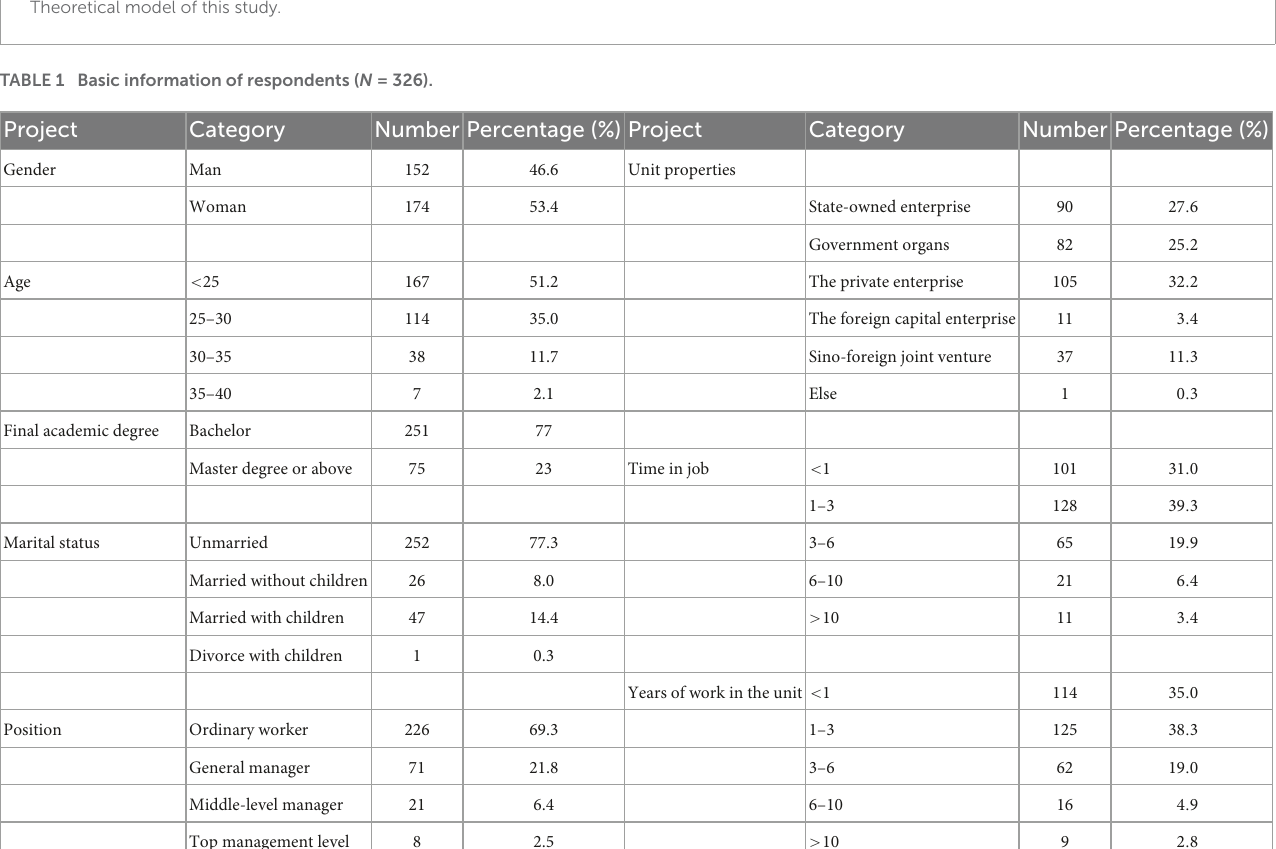
FIGURE1 Theoretical model of this study.